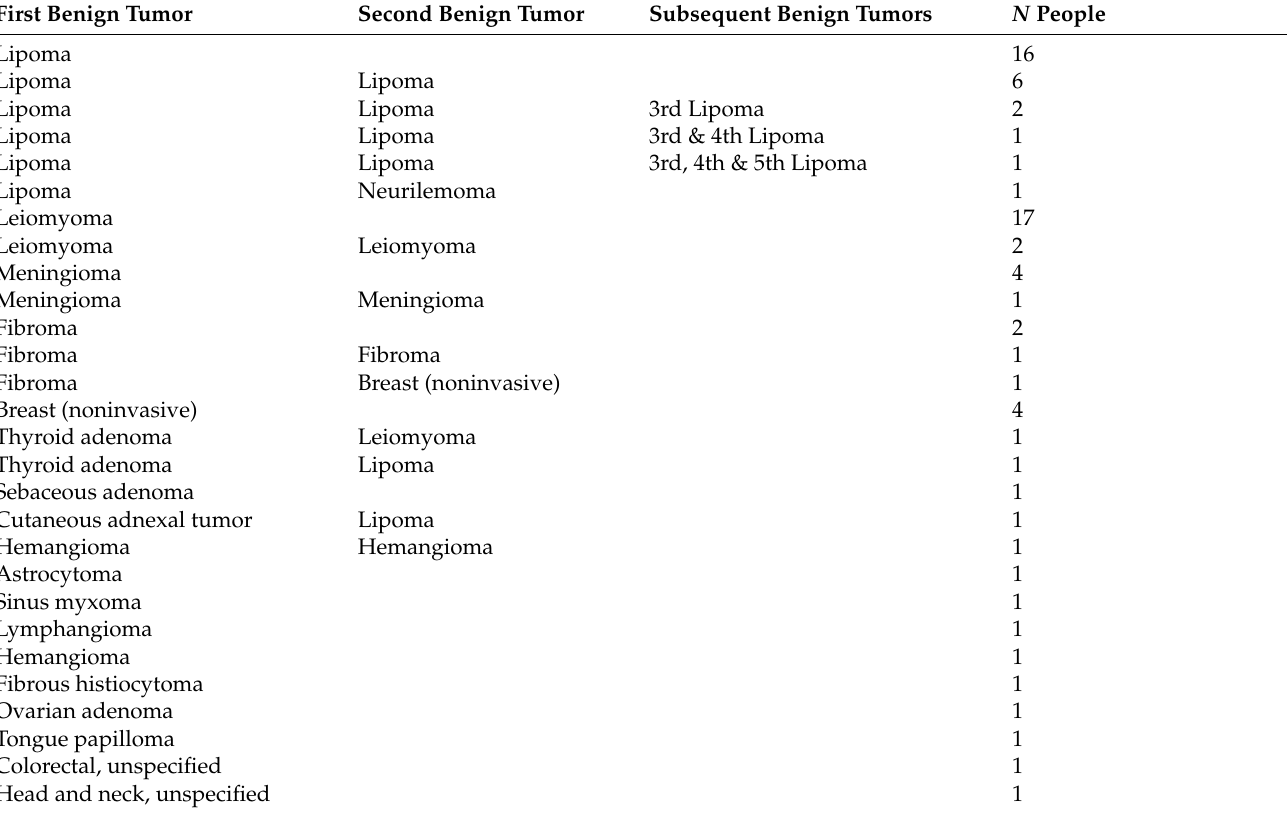
Table 2. Patterns of benign tumors * among hereditary retinoblastoma survivors who reported at least one benign tumor during